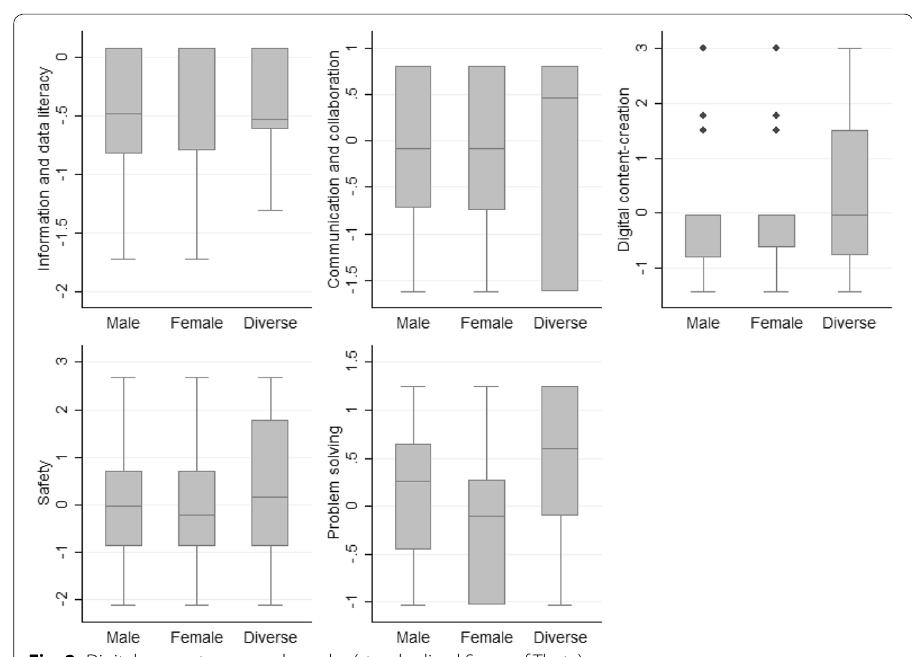
Fig. 2 Digital competences and gender (standardized Score of Theta)